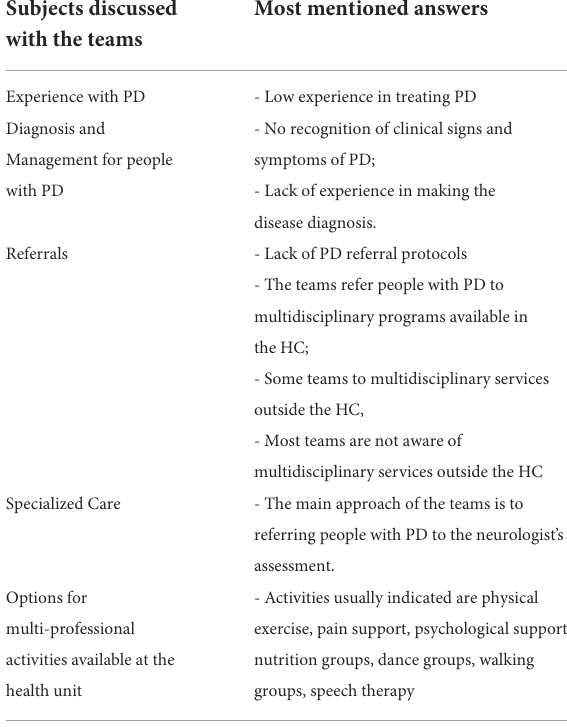
TABLE 1 Subjects and answers of the qualitative